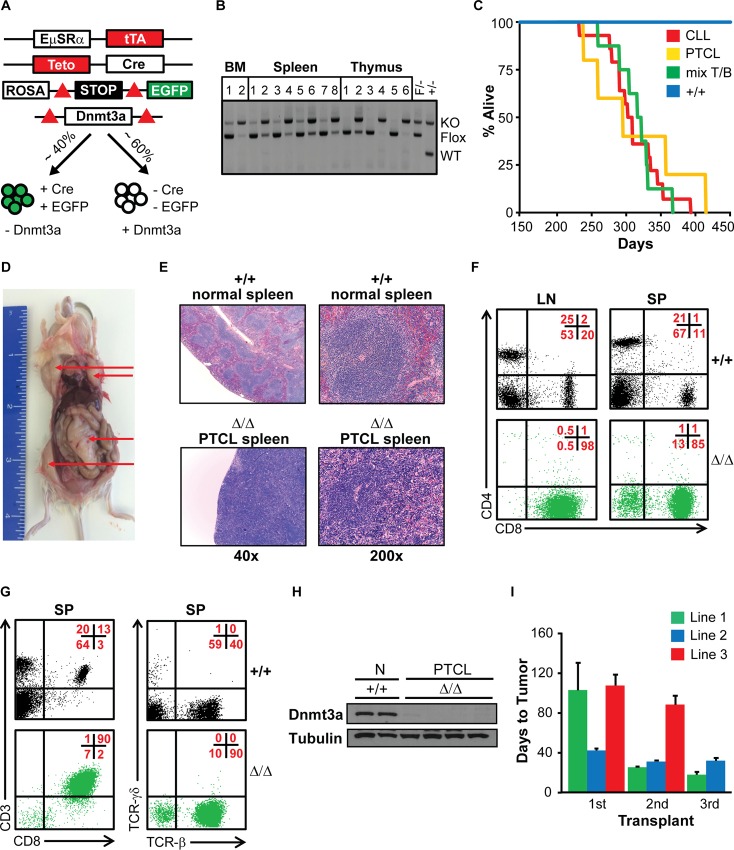
Dnmt3aΔ/Δ mice develop B220+CD19+CD5+ CLL and CD8+ PTCL.(A) Genetic setting used to conditionally delete Dnmt3a. The tetracycline activator protein (tTA) is expressed in ~40% of all hematopoietic cells (including stem cells). tTA promotes expression of the Teto-Cre transgene. Expression of Cre results in the excision of the stop cassette located upstream of the Rosa26LOXPEGFP reporter locus and deletion of Dnmt3a within the same subpopulation of cells. Thus, inclusion of the EGFP transgene allows for monitoring cells expressing tTA, and Cre, as well as to identify cells deleted for Dnmt3a. (B) PCR-based genotyping of the Dnmt3a locus using DNA isolated from FACS-sorted EGFP-positive (+) and EGFP-negative (−) populations on cells obtained from the bone marrow (BM), spleen (SP) and thymus (TH) of 6-week-old Dnmt3a−/− mice. PCR reactions were performed on samples in the following order, BM: (1) -LSK, (2) +LSK, SP: (1) -B2, (2) +B2, (3) -B1, (4) +B1, (5) -myeloid, (6) +myeloid, (7) -erythroid, (8) +erythroid, TH: (1) -DP, (2) +DP, (3) -CD4, (4) +CD4, (5) -CD8, (6) +CD8. Immunophenotypes of sorted populations are as follows: LSK (Lineage-, Sca-1+, ckit+), B2 (B220+, CD5-), B1 (B220+, CD5+), Myeloid (CD11b+), erythroid (Ter119+), DP (CD4+, CD8+), CD4 (CD4+, CD8-), CD8 (CD4-, CD8+). Fragments from floxed (F), wild-type (WT) and knockout (KO) alleles are shown. DNA from conventional Dnmt3a heterozygous (F/- and +/-) mice were used as controls. (C) Kaplan Meyer survival curve for Dnmt3aΔ/Δ mice. Moribund mice were classified at the time of terminal harvest with CLL (red), PTCL (yellow), or mixed CLL/PTCL (green) based on the presence of B-1a or CD8+ T cells tumors, as determined by FACS. Dnmt3a+/+
wild-type (+/+) controls are shown in blue. (D) A terminally ill Dnmt3aΔ/Δ mouse with PTCL. Generalized lymphadenopathy is denoted by arrows. (E) H&E stained sections of Dnmt3a+/+ (normal) and Dnmt3aΔ/Δ (PTCL) spleens (40X and 200X). (F) CD8 and CD4 expression in cells isolated from the lymph nodes (LN) and spleens (SP) of Dnmt3a+/+ control (+/+) and Dnmt3aΔ/Δ PTCL (Δ/Δ) mice as determined by FACS. Percentages of cells in each quadrant are shown in the top right in red. (G) CD3, CD8, TCR-β and TCR-γδ expression in cell isolated from the spleens (SP) of Dnmt3a+/+ control (+/+) and Dnmt3aΔ/Δ PTCL (Δ/Δ) mice, as determined by FACS. (H) Immunoblot showing Dnmt3a protein levels in Dnmt3a+/+ normal (N) controls (+/+) and Dnmt3aΔ/Δ PTCL (Δ/Δ) lymph node samples. γ-tubulin is shown as a loading control. (I) Time to tumor for primary (1), secondary (2) and tertiary (3) sub-lethally irradiated FVB-recipient mice serially transplanted with CD8+ PTCL tumors isolated from the lymph nodes of Dnmt3a
Δ/Δ terminally sick mice. Data are presented as average time to tumor development. Three PTCL lines are shown.